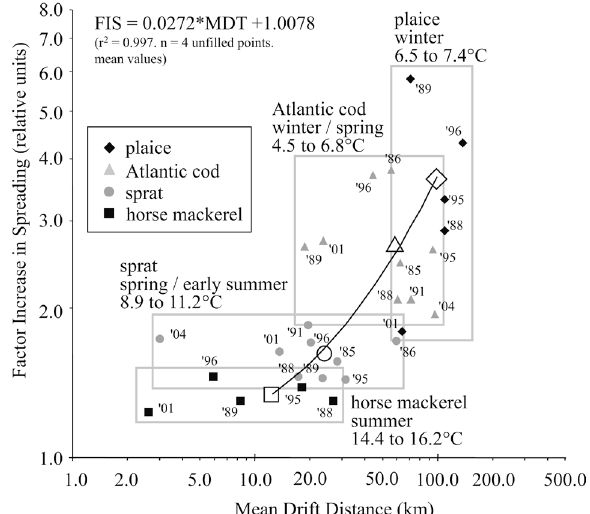
F IG . 6. – Factor increase in spreading area (final release area divided by initial release area) versus drift distance (km) for plaice (dia- monds), Atlantic cod (triangles), sprat (circles), and horse mackerel (squares). The regression equation describes the mean values calcu- lated for the four species. Rectangles have been drawn that outline the range in values for each species.